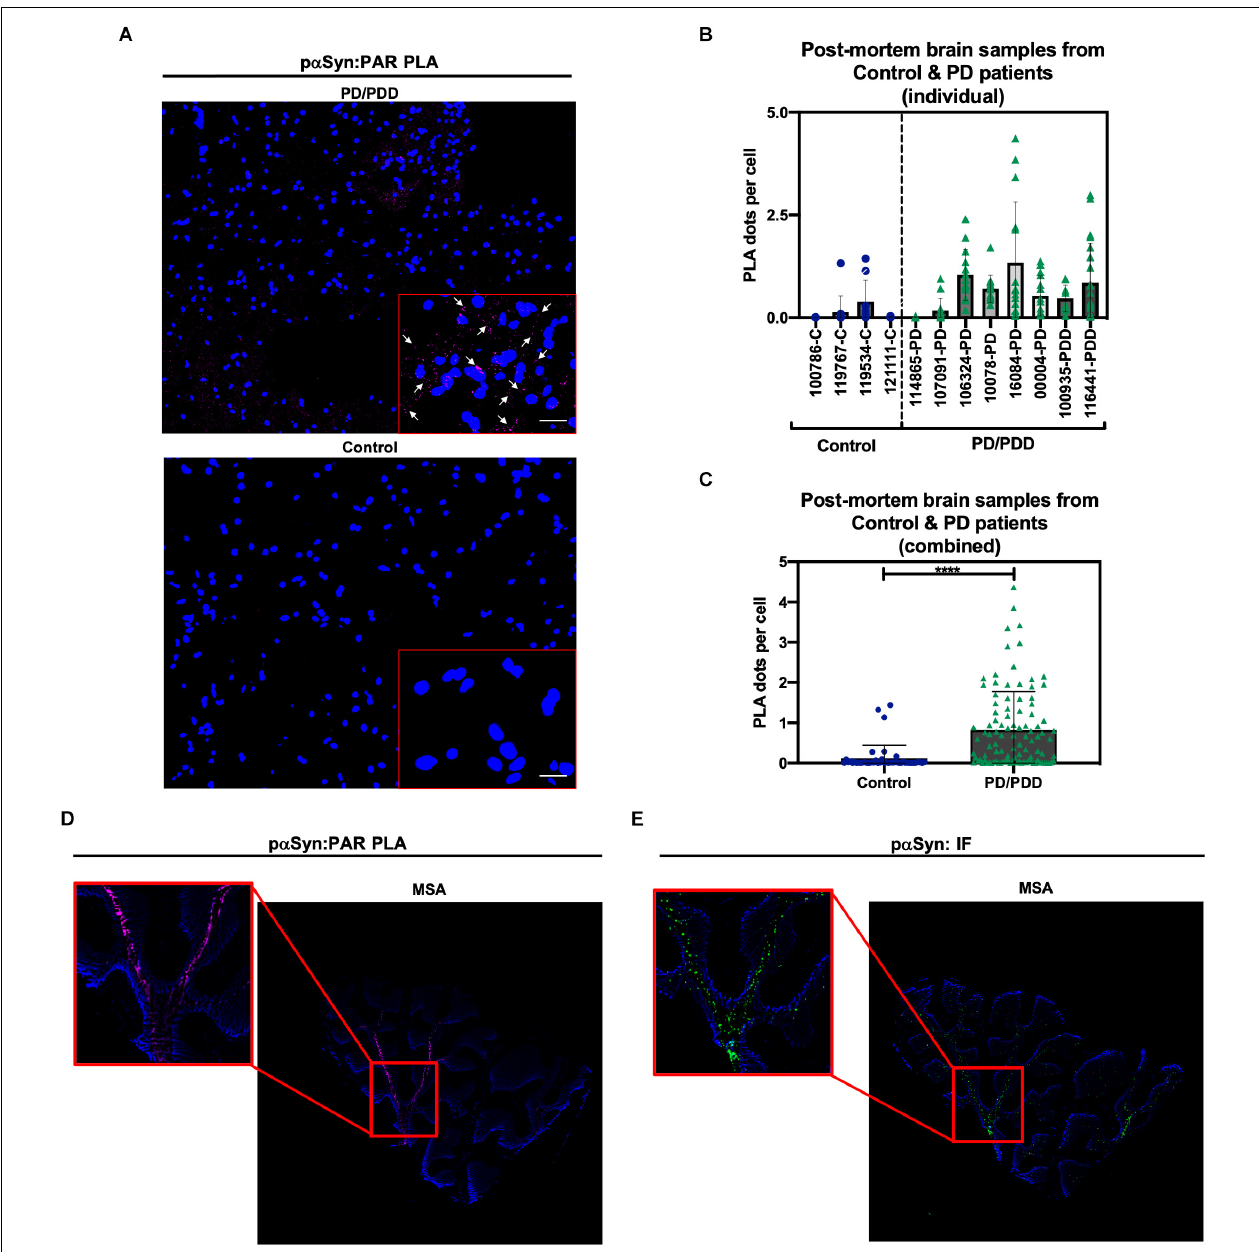
FIGURE 4 | Poly (ADP-ribose) predominantly interacts with p α Syn in PD/PDD post mortem patient samples. (A) Representative PLA and DAPI images in non-PD control ( top panel , tissue ID 121111, middle frontal gyrus) and PD/PDD patient samples ( bottom panel , tissue ID 116441, middle frontal gyrus). ROI overlaid on merge channel. ROI scale bar 10 µ m. Images were captured using Zeiss Axio Widefield (20 × /0.8) microscope. Representative white arrows showing PLA positive signal. (B) Quantification of PLA dot count per cell in individual non-PD control vs. PD/PDD patient samples. Bars represent means ± SD. (C) Combined PLA analysis for all control and PD/PDD tissue samples. Bars represent means ± SD. Student’s two-tailed t -test [ n = 4 (control) and 8 (PD/PDD) patient samples per group]. **** P < 0.0001. For (B,C) each graphical symbol represents the average number of PLA dots normalized to cell count (DAPI) for each field-of-view . 10–15 fields were captured for each patient sample. (D) PLA (pink) and DAPI (blue) signal from cerebellum sections derived from an MSA patient. (E) Standard immunostain of adjacent cerebellum sections from an MSA patient showing p α Syn (green) and DAPI (blue) channel images. Red boxes indicate PLA signal (D) and matching p α Syn IF (E) in adjacent MSA tissue sections. Images were captured using Zeiss Axio Widefield (20 × /0.8)